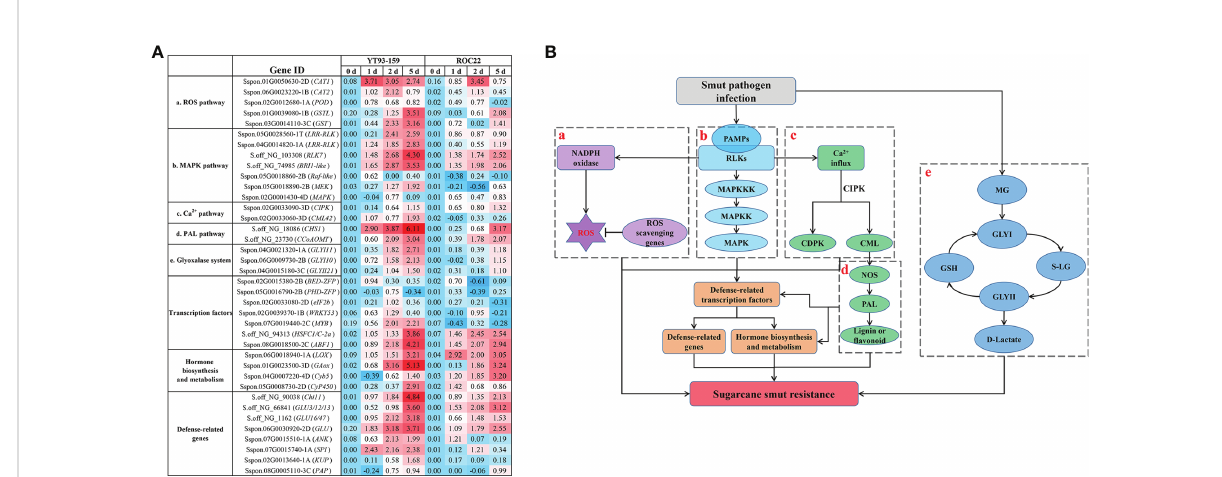
FIGURE 9 A potential molecular mechanism of sugarcane and S. scitamineum interaction. (A) A heat map of the key genes identi fi ed by BSR-Seq and WGCNA. Values indicate log ratios of relative expression levels of the key genes by RT-qPCR in YT93-159 and ROC22 at 0 d, 1 d, 2 d, and 5 d post S. scitamineum -inoculation. (B) The potential molecular mechanism diagram. a, ROS signaling pathway; b, MAPK cascade signaling pathway; c, Ca 2+ signaling pathway; d, PAL metabolic pathway; e, the glyoxalase system; PAMPs, pathogen-associated molecular proteins; RLKs, receptor-like kinases; ROS, reactive oxygen species; MAPK, mitogen-activated protein kinase; CIPK, calcineurin B-Like interacting protein kinase; CDPK, calcium-dependent protein kinase; CML, calmodulin like; NOS, nitric-oxide synthesis; PAL, phenylpropanoid; MG, methylglyoxal; GSH, glutathione; GLYI, glyoxalase I; GLYII, glyoxalase II; SD-lactoylglutathione